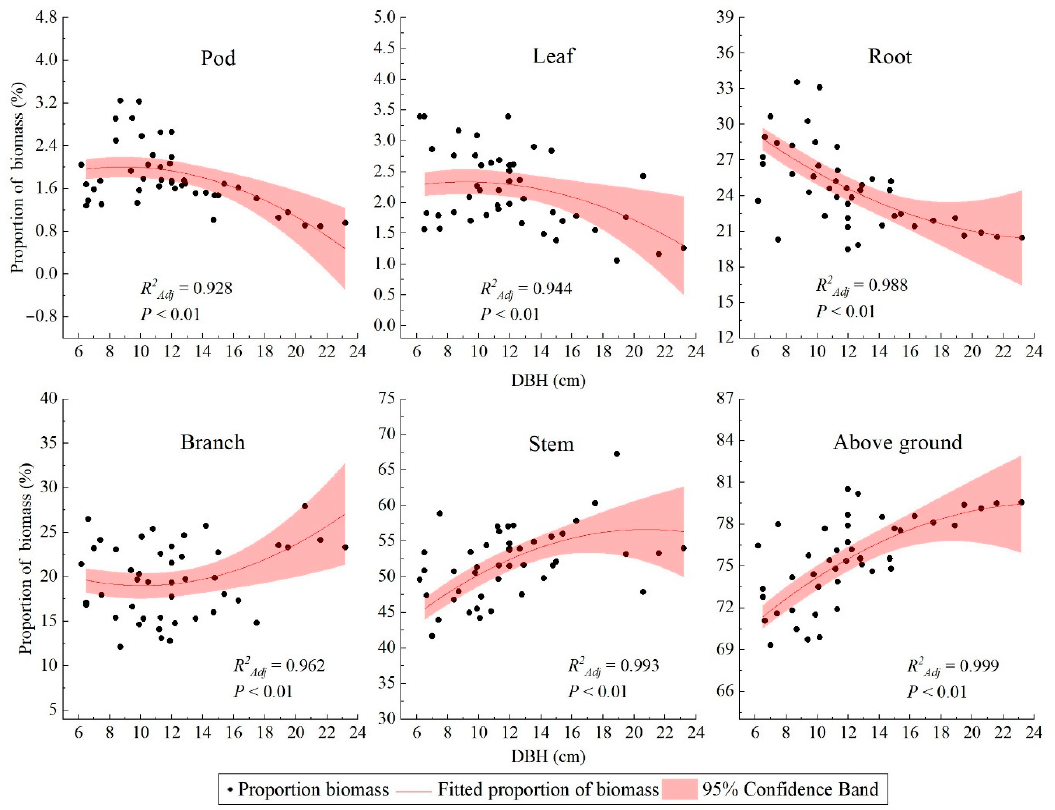
Figure 4. Variation in tree component mass fraction according to the diameter at breast height ( D ).